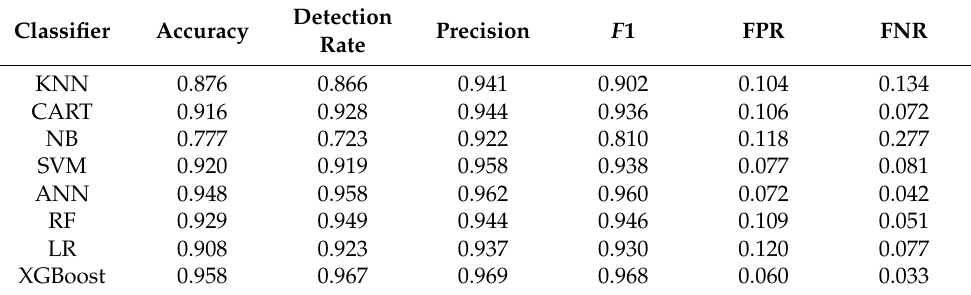
Table 5. Accuracy ( ACC ), Detection Rate ( DR ), Precision ( P ), F -measure ( F 1), False positive rate (FPR), and False negative rate (FNR) for the proposed models with k =